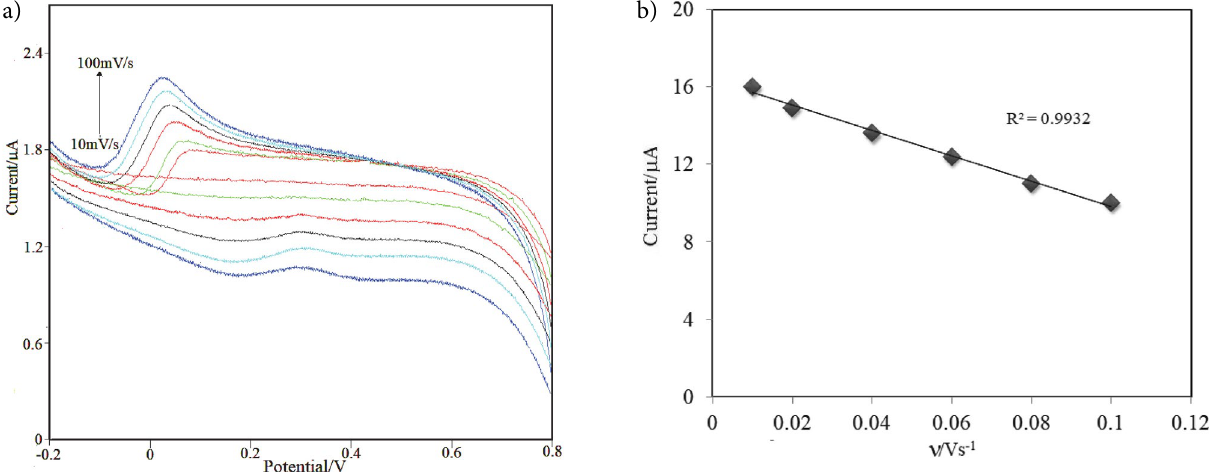
Figure 7. (a) CVs of Au/PANI/Pt electrode studied at various scan rates: 10, 20, 40, 60, 80, and 100 mVs –1 with 1 mM glucose in 0.1 M NaOH. (b) Plot of I p vs. scan rate.